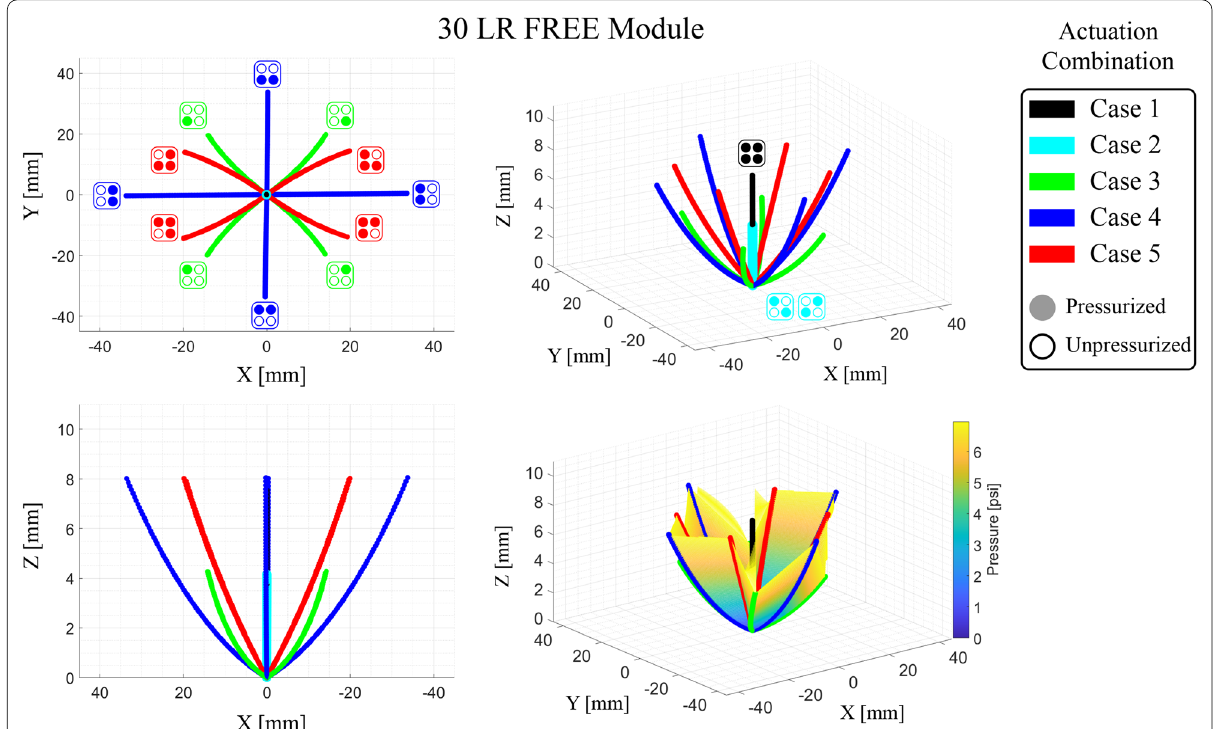
Fig. 9 Orthogonal and three-dimensional views of the reachable end-effector positions for 30 LR-module. The plots show the paths taken by the module’s end-effector as the FREEs are pressurized from 0 to 7 psi based on actuation cases 1 through 5. The variations of each case are shown with activation indicators (top view of the end-effector consistent with Fig. 6) in the X-Y and X-Z planes. The plot in the bottom right illustrates the linearly interpolated estimate of the workspace of the module. All FREEs are modeled with 130 mm length, 9.52 mm inside diameter, and 0.8 mm wall